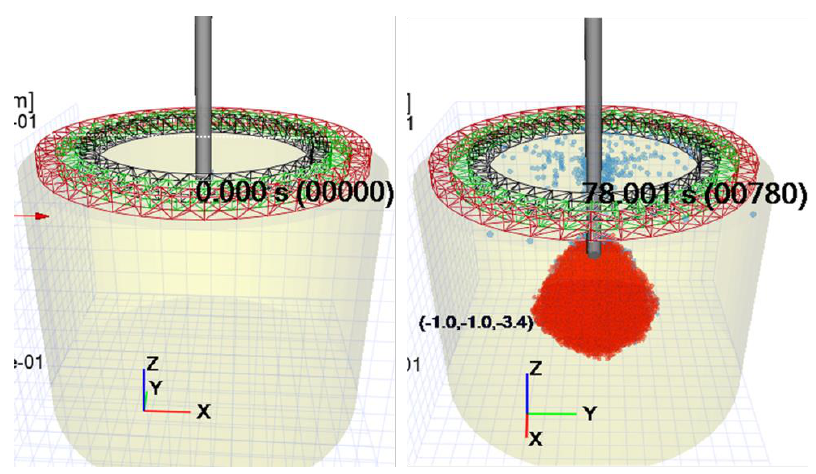
Figure 5. Front views of probe region at beginning and end.